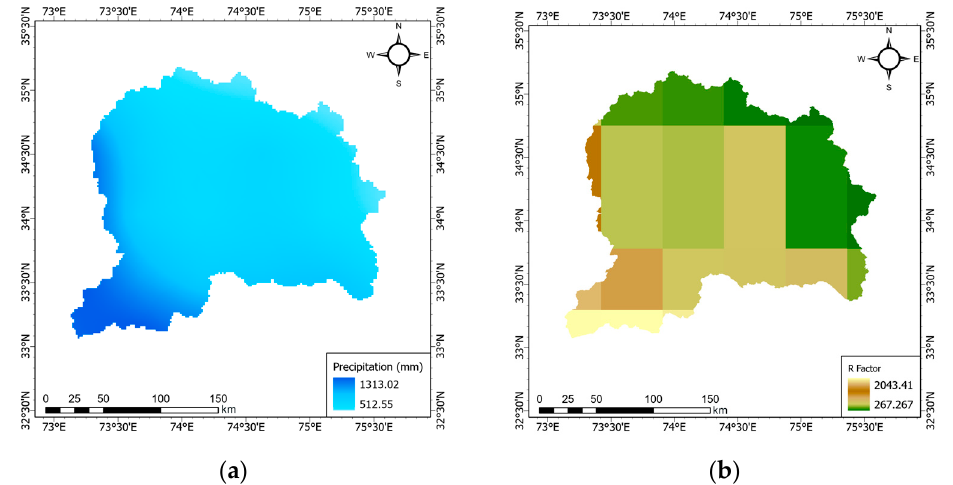
Figure 3. ( a ) Map of mean annual rainfall; ( b ) distribution of rainfall erosivity (R-factor).